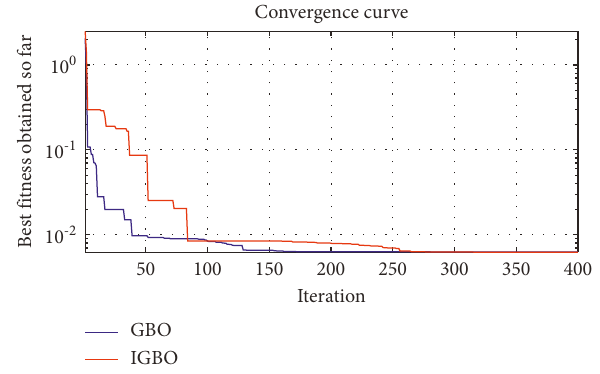
Figure 14: SAE convergence for model